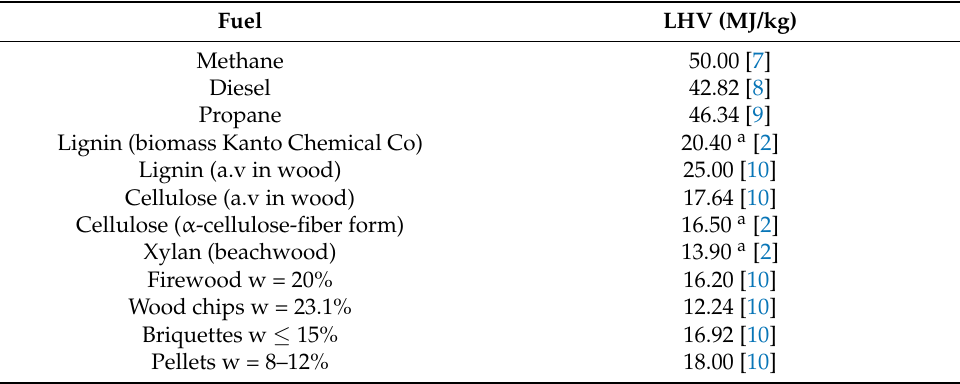
Table 2. LHV of the main fuels used in boilers.